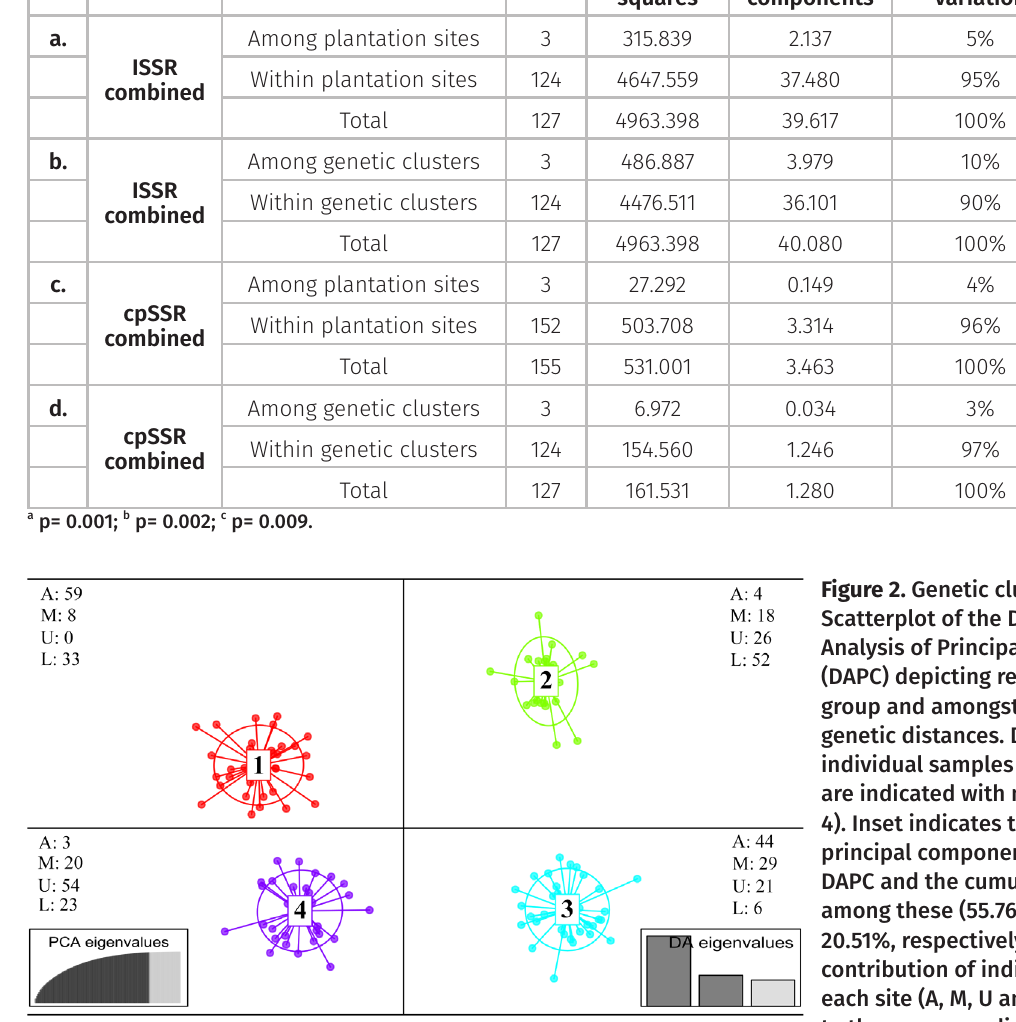
Source Variation df